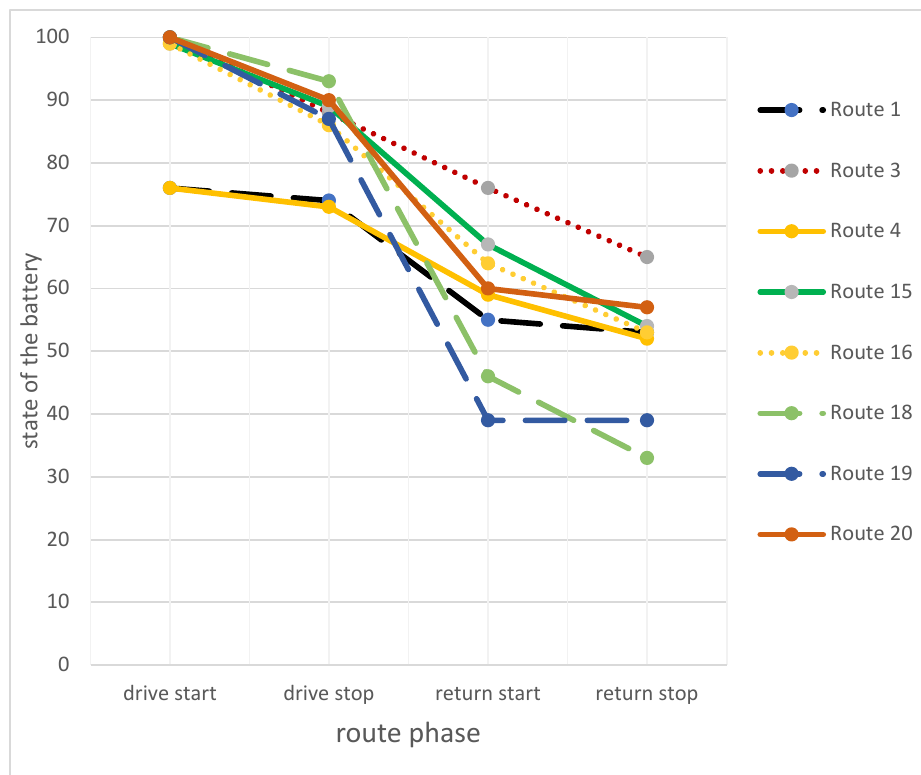
Figure 5. Charge status change depending on the nature of the route segment. Source: Own study. (Ad. Figure 4c) In order to carry out an analysis related to the energy consumption